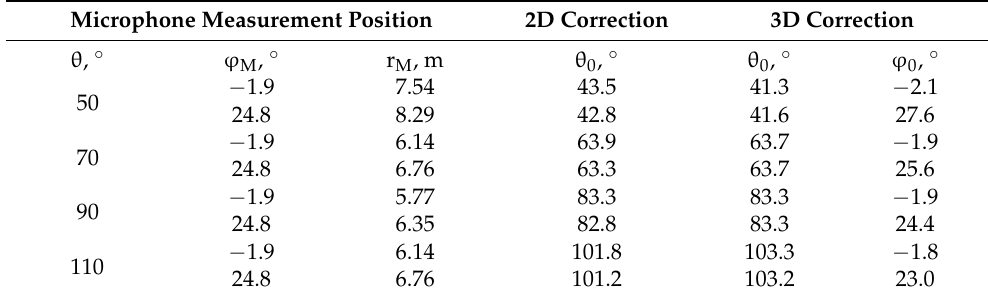
Table 1. Amiet’s angle correction for the landing gear model with the highest leg in FL-17 CARDC for the flow speed 75 m s − 1 .